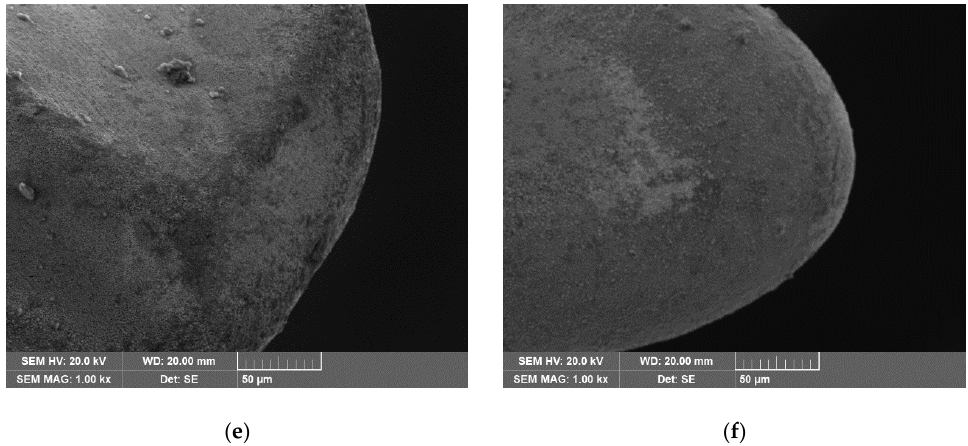
Figure 6. Partial view of the tool wear under different voltages: ( a ) the base tool; ( b ) 28 V, 500 Hz, 50%, 15 wt%, 2000 rpm; ( c ) 28 V, 500 Hz, 50%, 15 wt%, 2000 rpm; ( d ) 52 V, 500 Hz, 50%, 15 wt%, 2000 rpm; ( e ) 52 V, 500 Hz, 50%, 15 wt%, 2000 rpm; and ( f ) 58 V, 500 Hz, 50%, 15 wt%, 2000 rpm.